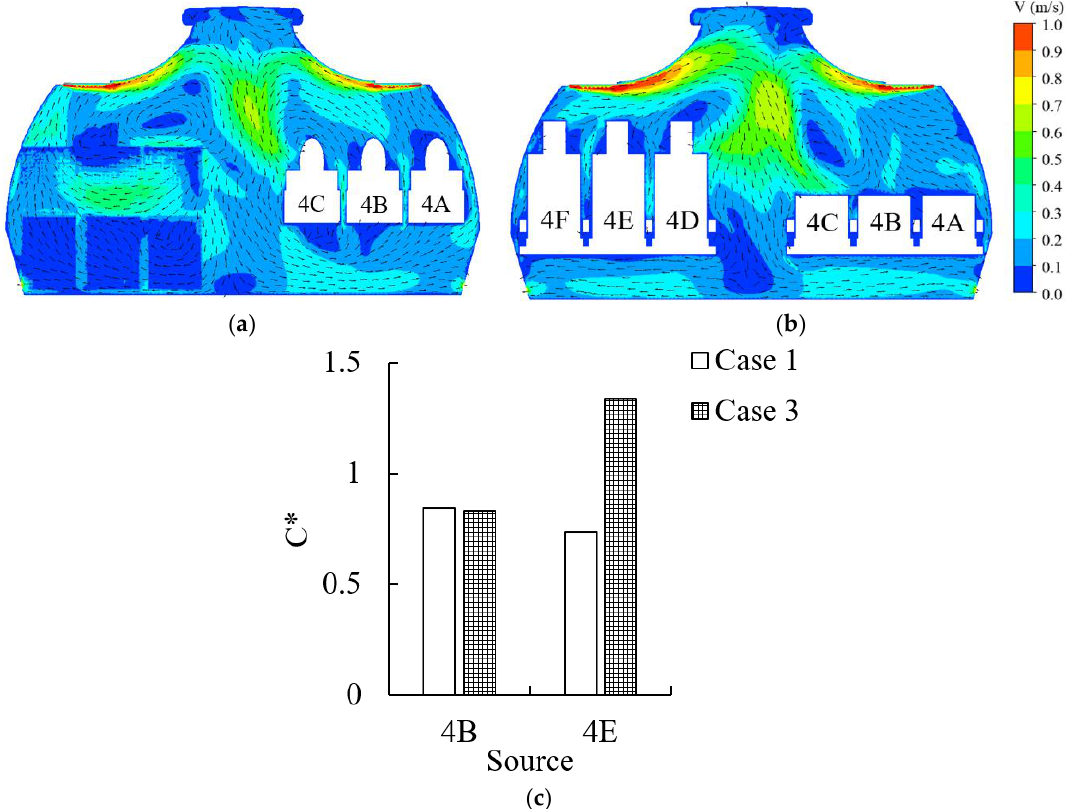
Figure 9. Airflow and normalized pollutant concentrations with all of the seats A to C inclined in Case 3: ( a ) airflow field in the cross-section across the head of 4B, ( b ) airflow field in the cross-section